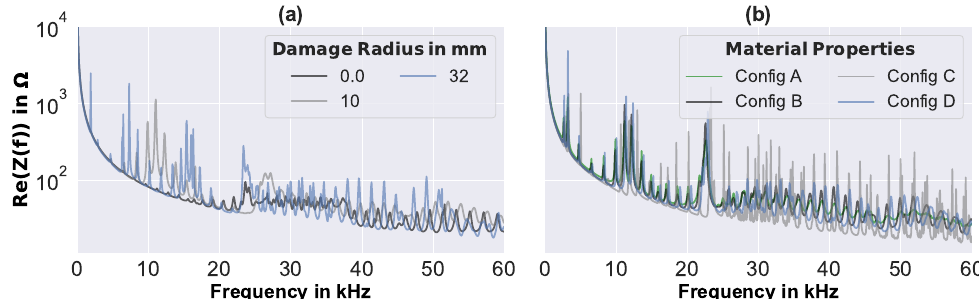
Figure 3. Examples of synthetic EMI spectra simulated by the FE model of the sandwich plate, with different arbitrarily selected material properties and ( a ) different debonding sizes, ( b ) debonding radius of